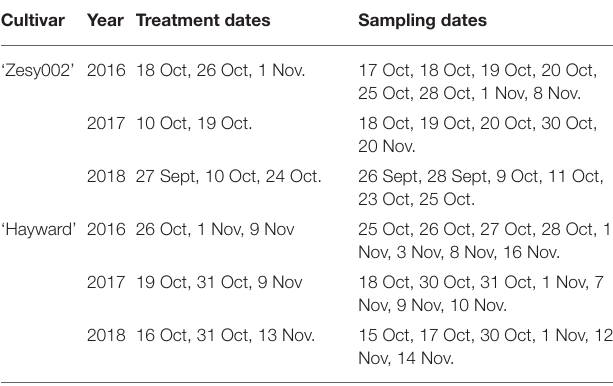
TABLE 1 | Treatment dates and sampling dates for the orchard trials conducted on Actinidia chinensis var deliciosa ‘Hayward’ and A. chinensis var chinensis ‘Zesy002’ in 2016, 2017, and